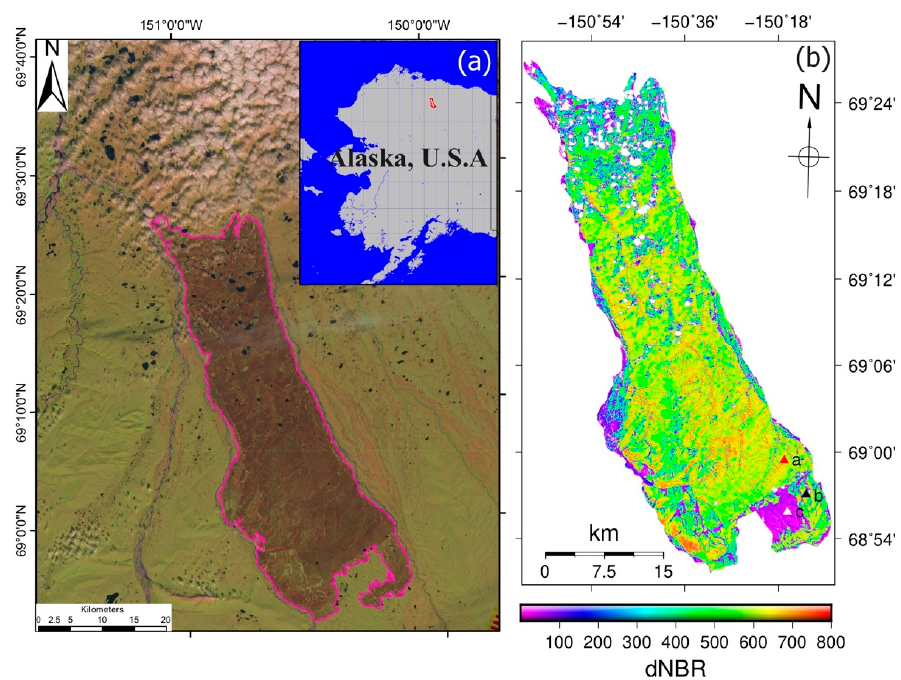
Figure 1. The location and burn severity of the Anaktuvuk River Fire (ARF). ( a ) the False-color Landsat-5 image acquired on 17 July 2008, the pink polygon is the fire boundary and the red polygon of upper left map shows the location of the fire area in Alaska. ( b ) differenced Normalized Burn Ratio (dNBR) within the burn scar [50]. The red, black, and white triangles (labeled as ‘a’, ‘b’, and ‘c’) mark the locations of severely and moderately burned, and unburned sites to be examined in our analysis, respectively.